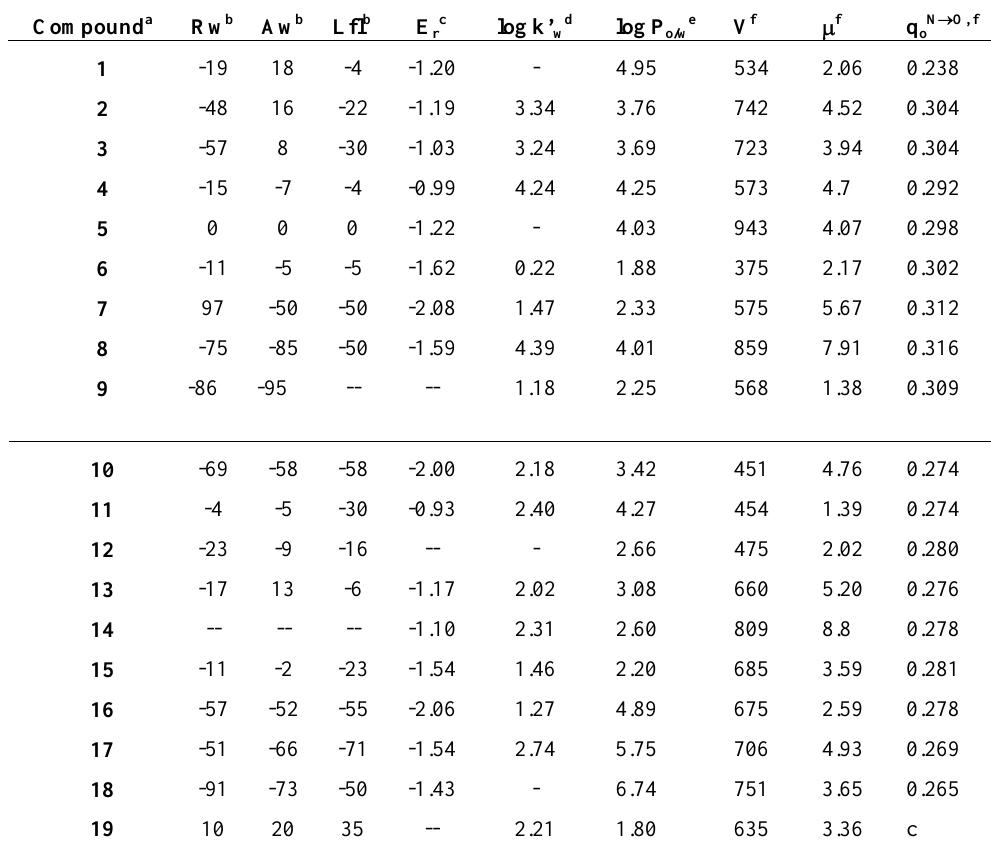
Table 1: Herbicidal activity indexes for the N -oxide derivatives and some of their experimental and calculated descriptors.